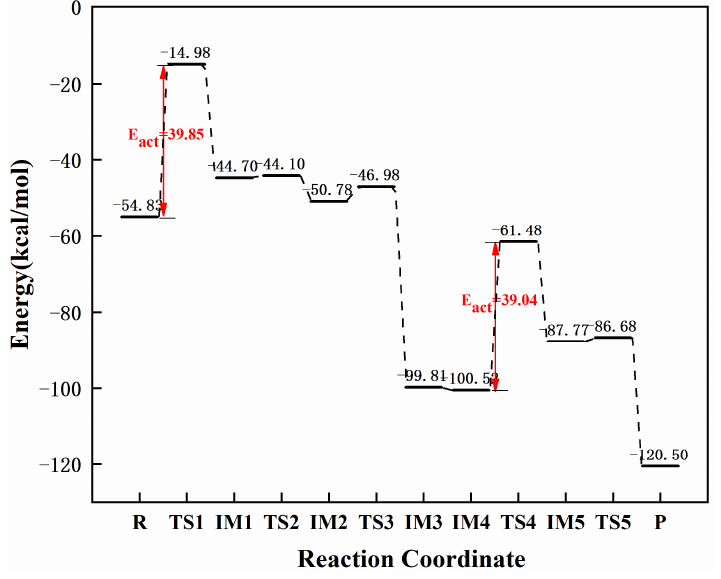
Figure 14. The most favorable energy path diagram for the hydrogenation of acetylene on graphene-NiN 3